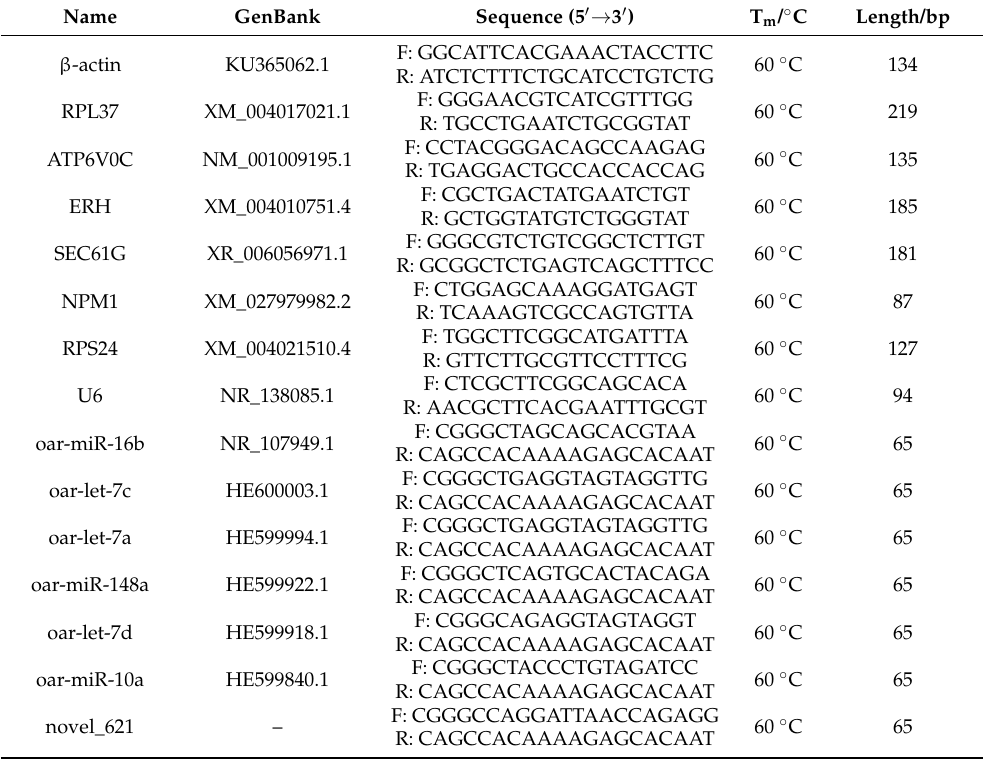
Table 1. qPCR primer